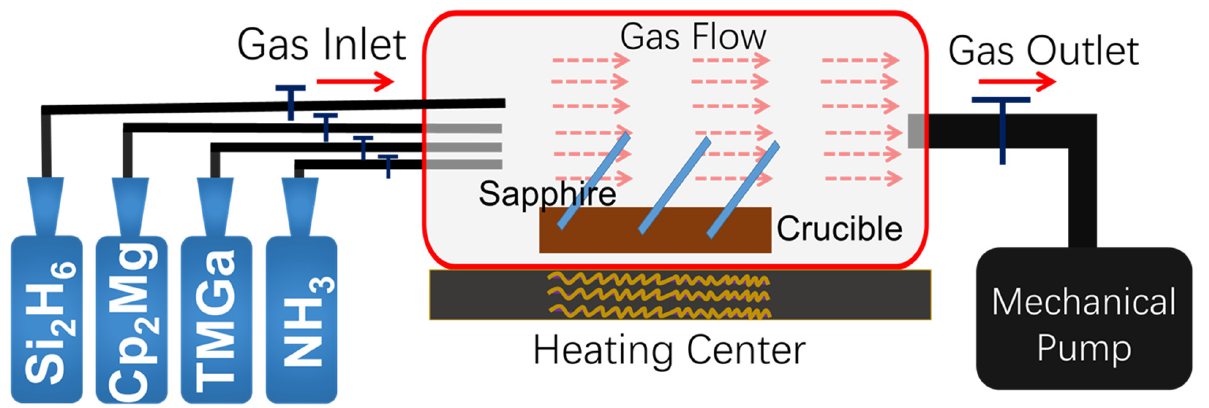
Figure 1. Schematic illustration of the growth of the undoped, Si-doped, and Mg-doped GaN thin films by using the MOCVD